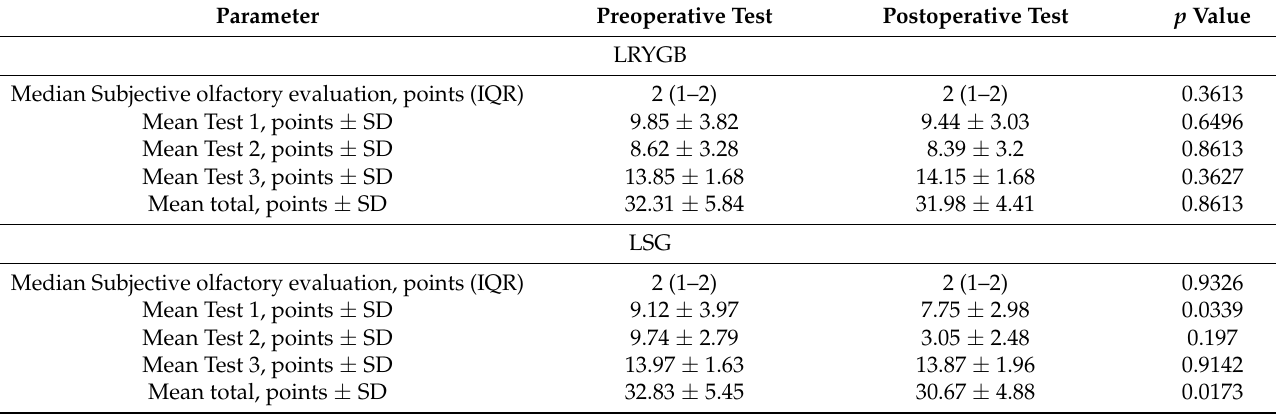
Table 3. Test results in LRYGB and LSG